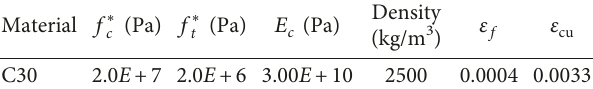
Table 3: Mechanical properties of